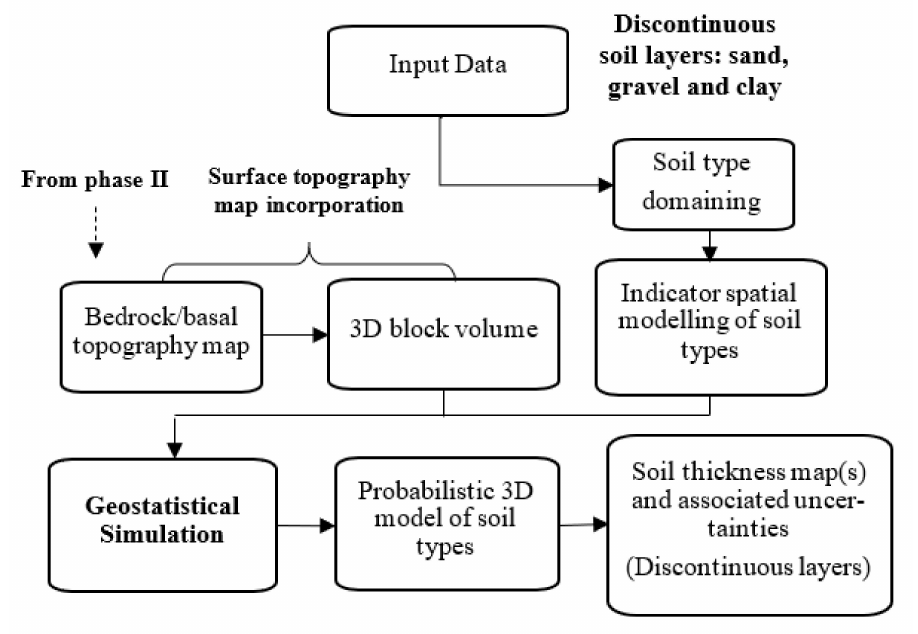
Figure 4. Phase III: methodology for determining soil thickness map(s) and associated uncertainties of discontinuous soil layers using geostatistical